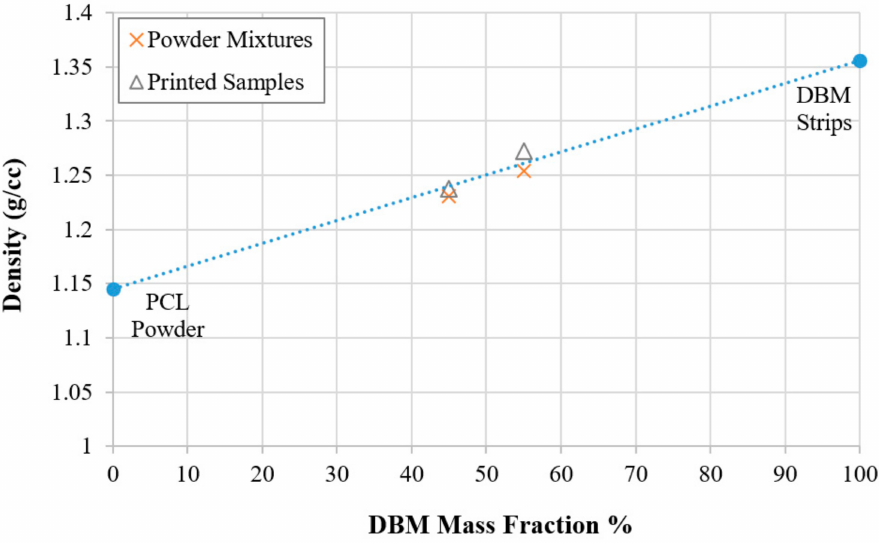
Figure 13. The variation of the density based on the DBM content in the powder stock.